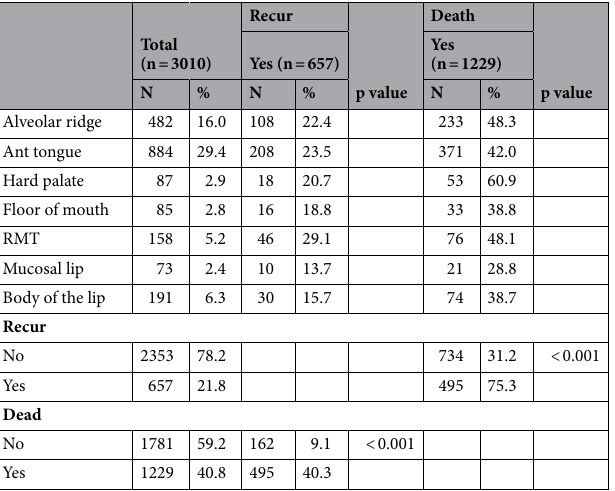
Table 2. Results of univariable analysis for cancer recurrence or death among patients.